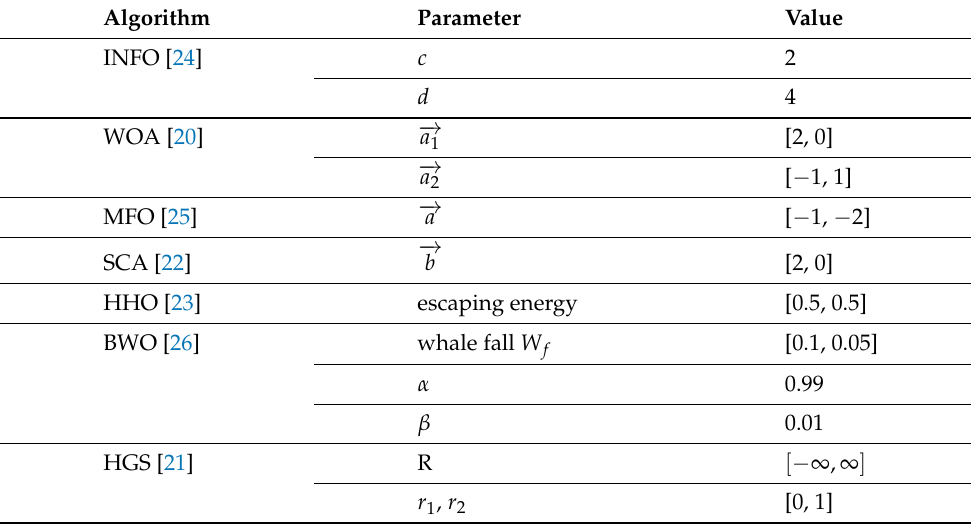
Table 2. All used algorithms’ parameter settings. Algorithm